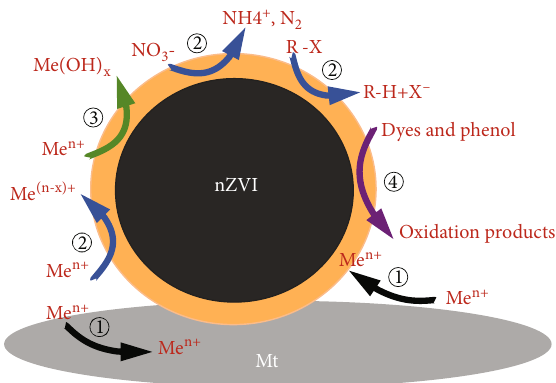
Figure 6: Schematic model of reaction mechanisms of Mt-nZVI with various